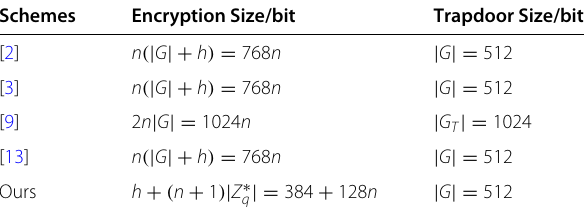
Table 3 Communication cost